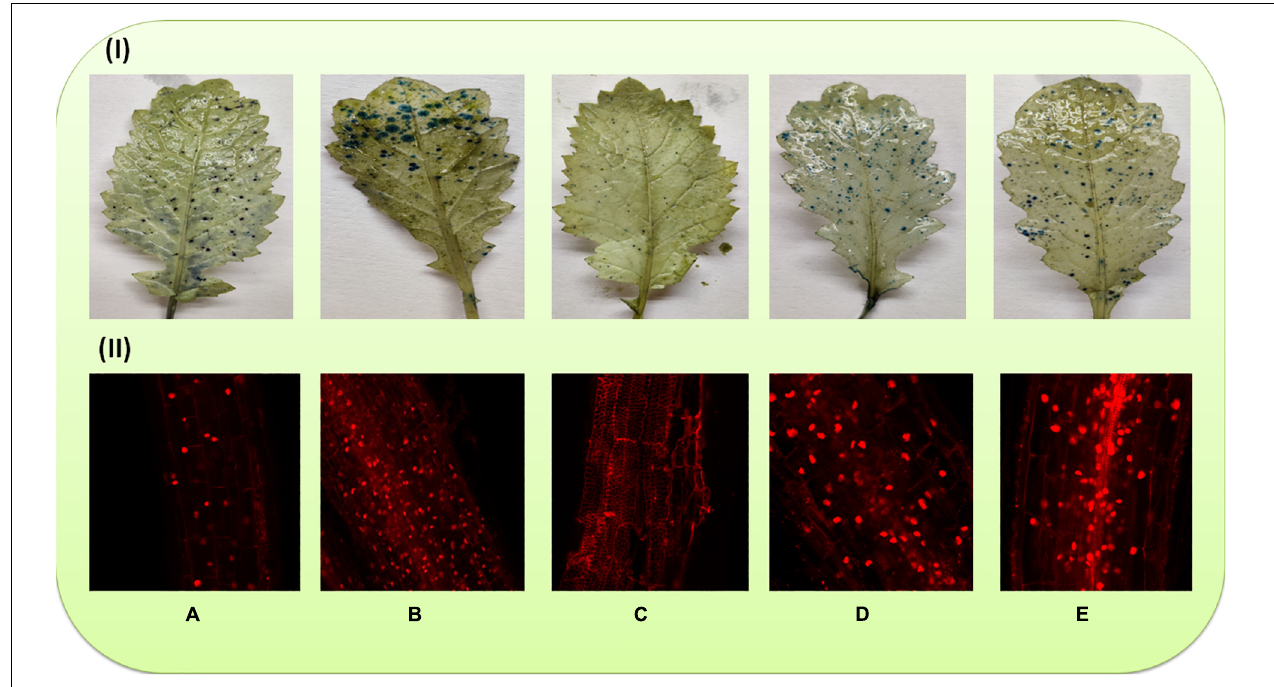
FIGURE 4 | Cell death in the leaves and roots of 45-day-old B. juncea (L.) cv. Varuna raised with Cu and/or sprayed with MEL. (A) Control, (B) Cu 60 mg kg − 1 , (C) MEL µ M, (D) Cu 30 + MEL (40 µ M), and (E) Cu 60 + MEL (40 µ M).